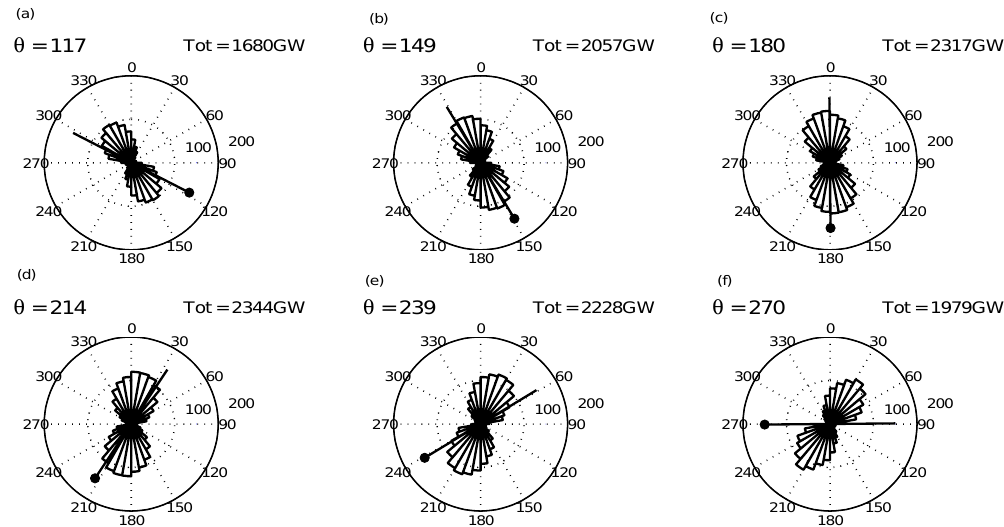
Fig. 2. (a) – (f) The distributions of energy transfer in the GUMICS-4 simulation, for different clock angles ( θ ). The clock angle is indicated by the black line and given in the legend. The energy transfer distributions are normalized to the outer circle (200GW), and the total net energy transfer for each time instant is also given in the legend.